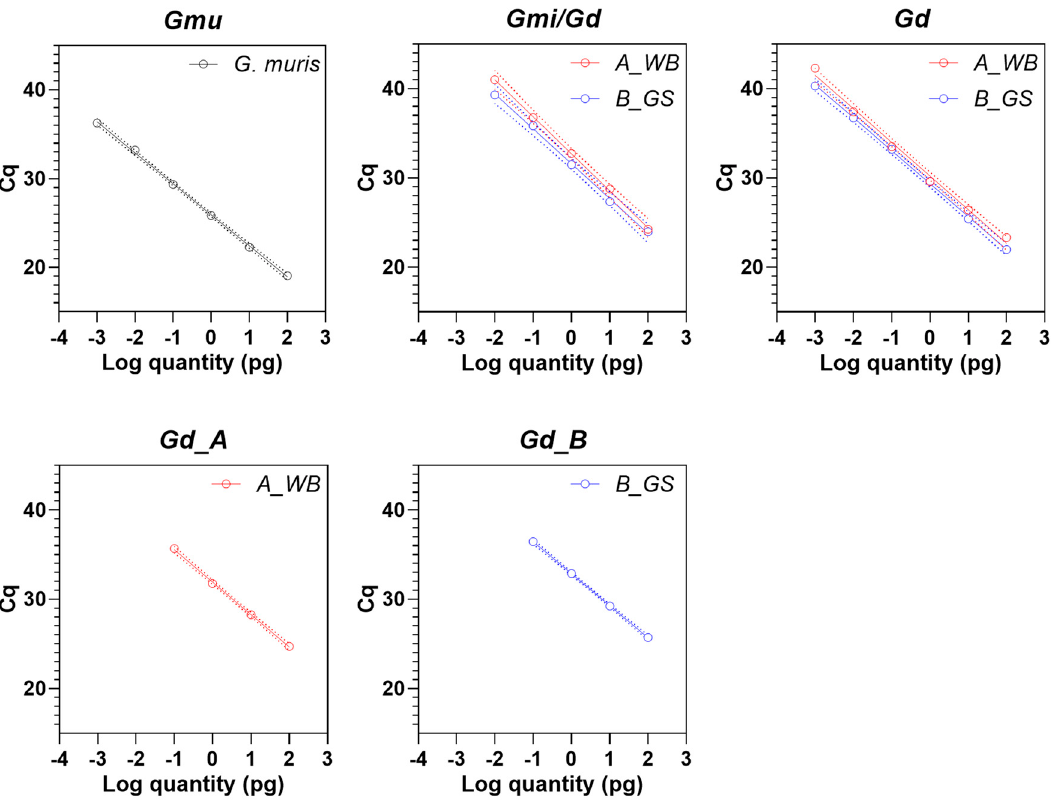
Figure 3. Analytical sensitivity of the real-time PCR assays used in the study. The G. muris -specific PCR ( Gmu ) was done with DNA from purified cysts. G. microti/G. duodenalis PCR ( Gmi/Gd ), G. duodenalis -specific PCR ( Gd ), G. duodenalis assem-blage A-specific PCR ( Gd_A ) and G. duodenalis assemblage B-specific PCR ( Gd_B ) was done using the DNA of axenic trophozoite cultures of assemblage A isolate WB ( A_WB ) and of assemblage B isolate GS ( B_GS ).